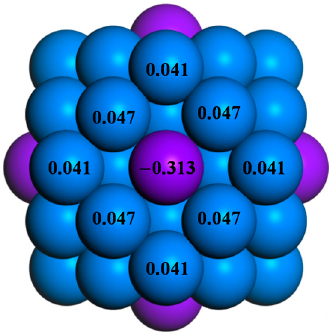
Figure 8. The density functional theory (DFT) calculated Mulliken charge on selected Rh atom and Ni